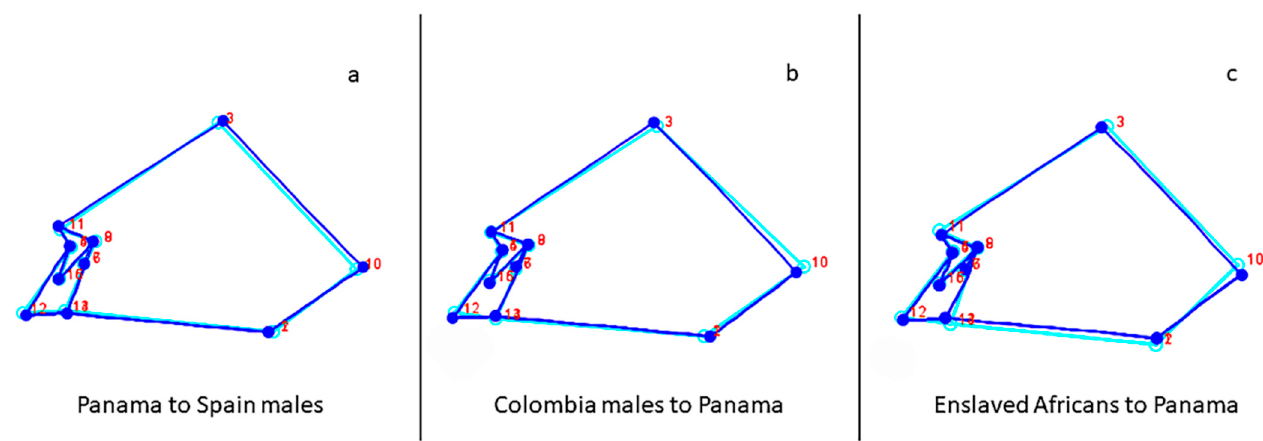
Figure 3. Wireframes depicting the ( a ) Panama (light blue) into Spanish males (blue); ( b ) Colombian males (light blue) into Panama (blue); ( c ) Enslaved Africans (light blue) into Panama (blue). Numbers correspond to landmarks in Table 2.